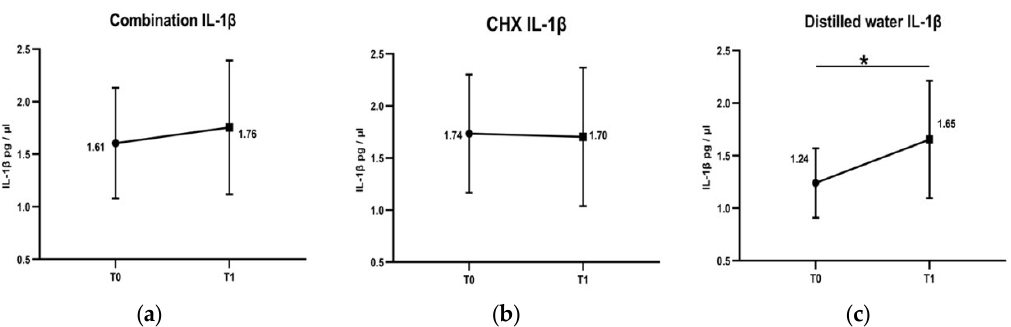
Figure 3. Changes of IL ‐ 1 β concentrations in GCF after rinsing with combination, chlorohexidine (CHX) and distilled water. T0 is at baseline day 0. T1 is at the 4th day. After rinsing with combination, there was a non-significant slight elevation in the concentration of IL-1 β ( a ). Rinsing with chlorohexidine (CHX) almost induced no changes in the concentration of IL-1 β ( b ). Whereas, concentration of IL-1 β was significantly increased after rinsing with distilled water ( c ). * Comparison by Wilcoxon signed-rank test, significance at p < 0.05.